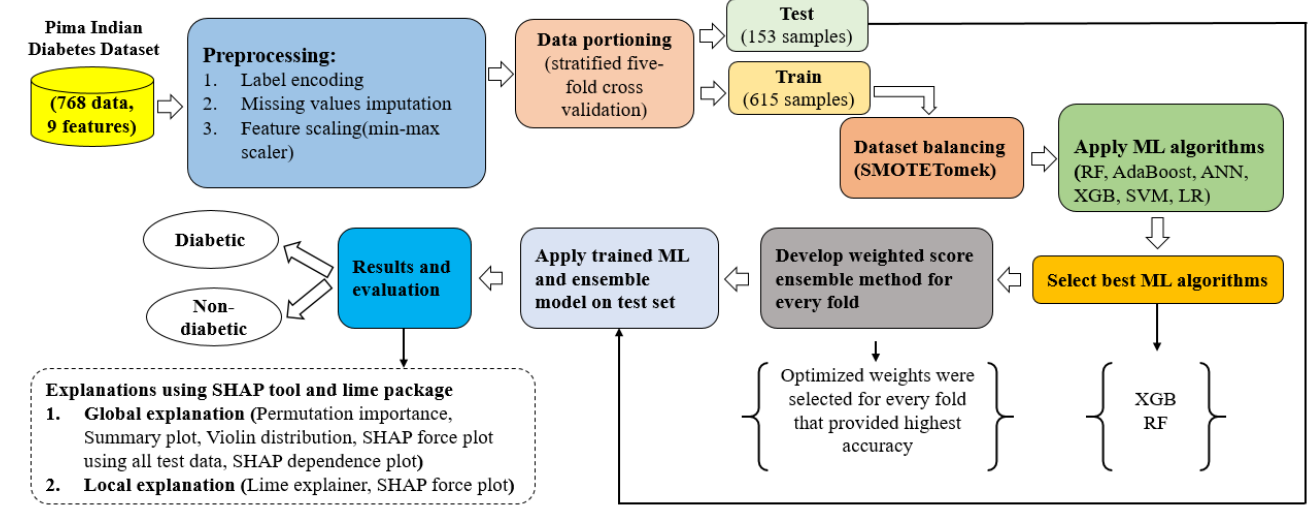
Figure 1. Overall workflow of the proposed diabetes detection model. Table 1. Description of the attributes available in the Pima Indian Diabetes dataset.